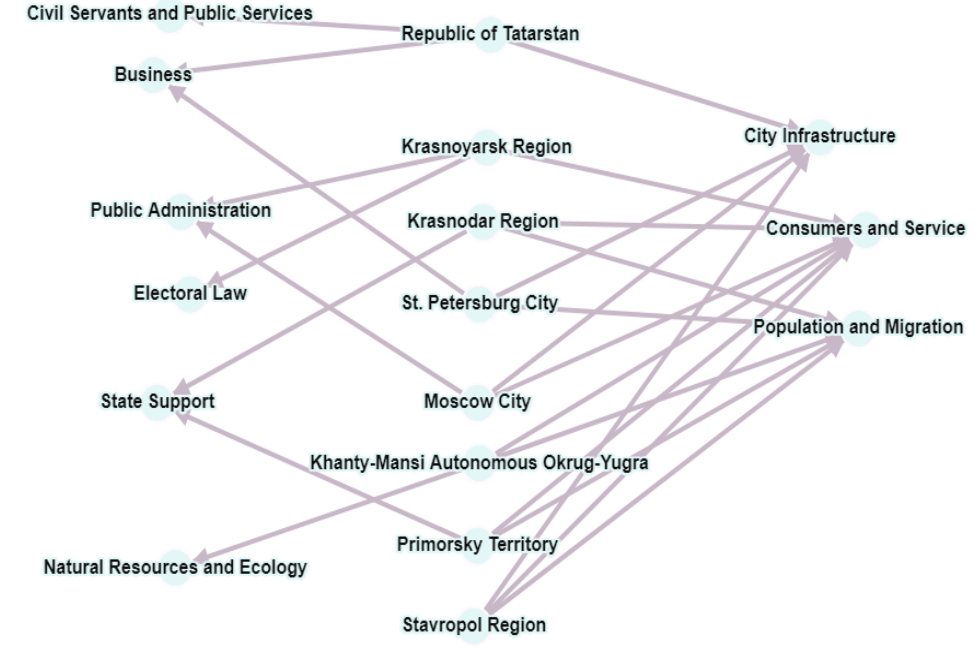
Figure 6. Leading regions in terms of the most popular network query topics (Google Trends analysis, March 2020–March 2021).